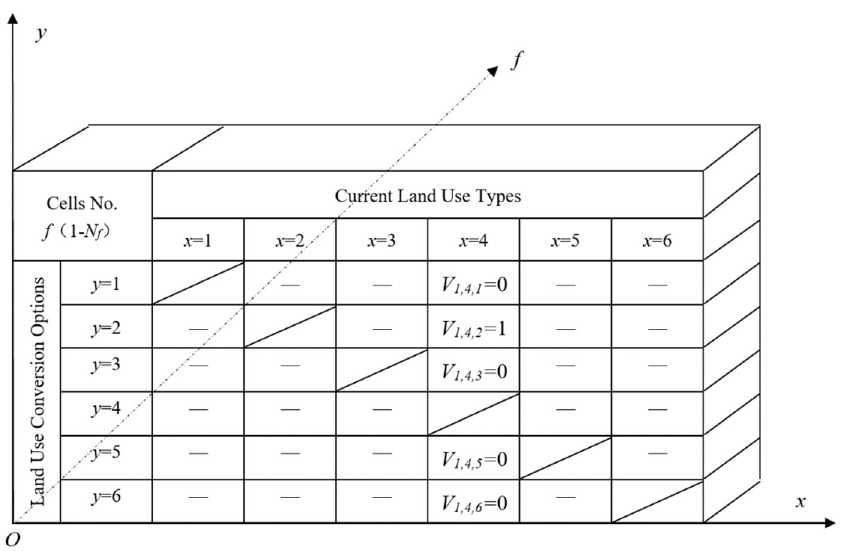
Figure 3. Binary transformation for land use type of cell f .